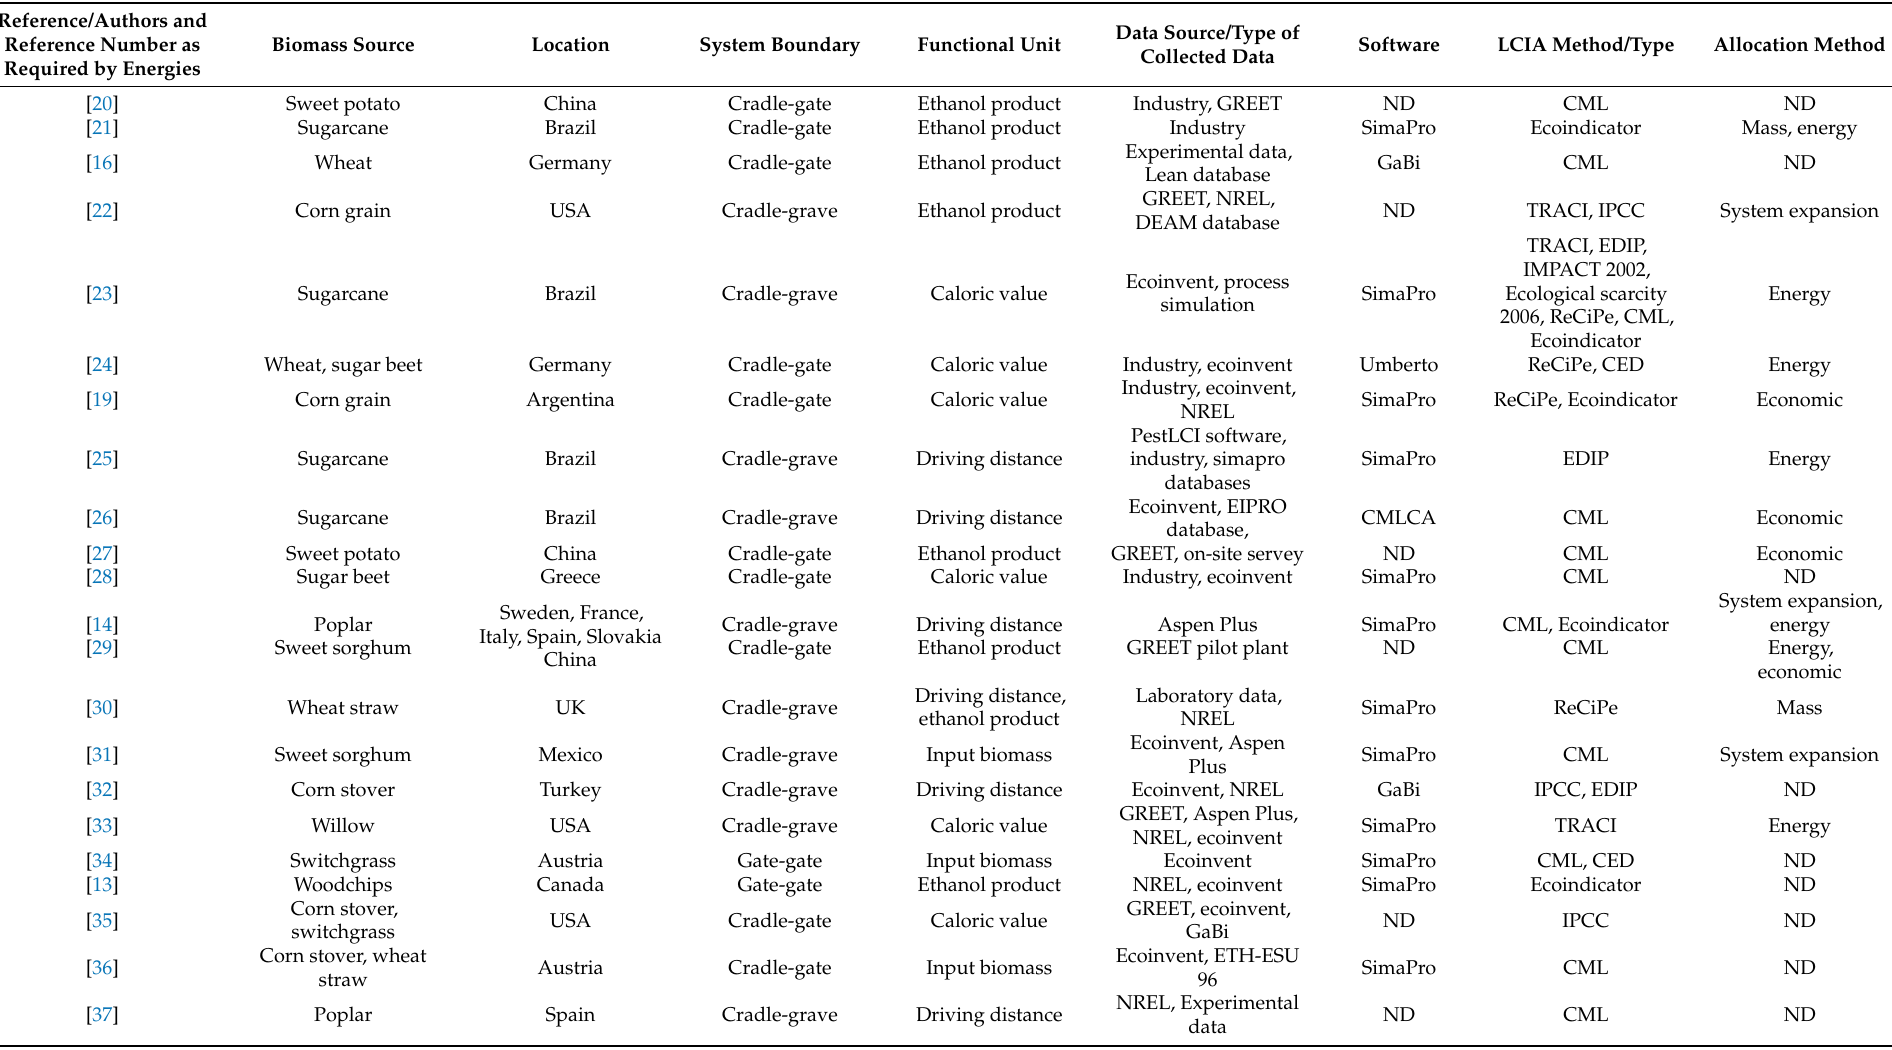
Table 1. Summary of the reviewed publications. (ND = not